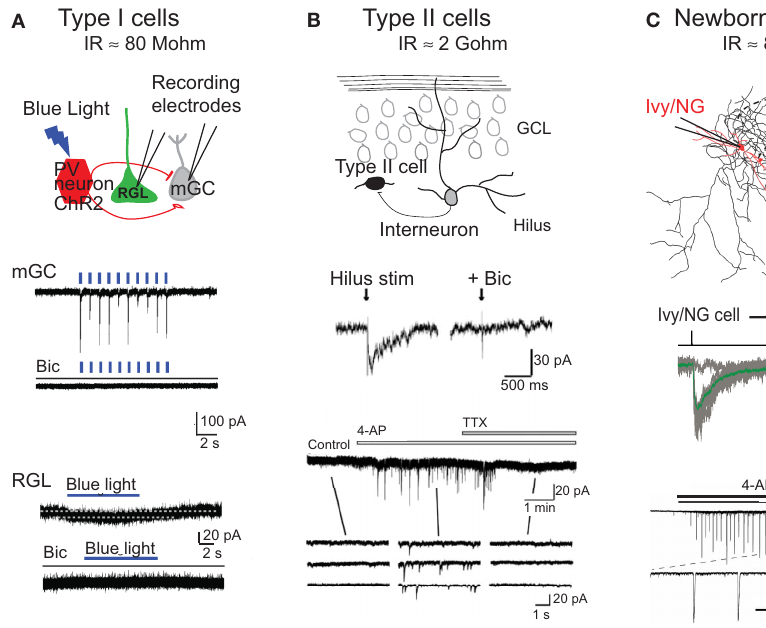
and dendrites, black axon) from a paired recording with a POMC-GFP + newborn GC (green). ML, molecular layer. Middle, current injection into presynaptic Ivy/NG cells evokes slow GPSCs in newborn GCs. The averaged unitary IPSC (green) is overlaid on individual currents (gray). From Markwardt et al. (2011). Bottom, bath application of 4-AP (100 μ M) induces synaptic currents in newborn GCs that are blocked by picrotoxin (PTX). Insets show currents on expanded time scales [scale bars are 200pA and 10s (left) or 500ms (right)]. From Markwardt et al. (2009). The estimate for IR of newborn GCs is from Overstreet et al. (2004). (D) Heterogeneous synaptic signaling to mature GCs: Top, schematic depiction showing that mature GCs are innervated by a variety of interneuron subtypes including Ivy/NG cells and perisomatic projecting interneurons. Ivy/NG cells also provide slow GABAergic inhibition to perisomatic-projecting interneurons. Middle, current injection in individual interneurons evokes either fast (left) or slow (right) uIPSCs in mature GCs, reflecting the heterogeneity of innervation. Bottom, spontaneous GPSCs in mature GCs arise from perisomatic-projecting interneurons (Soltesz et al., 1995). The frequency of sGPSCs is reduced by stimulation of the ML (arrows) that evokes slow NO711-sensitive IPSCs in mature GCs (insets) and perisomatic projecting interneurons (not shown). Together these results support the circuit diagram shown above. Scale in inset, 300pA, 500ms. Adapted from Markwardt et al. (2011). The estimate of IR for mature GCs is from Schmidt-Hieber et al. (2004) and Overstreet et al.